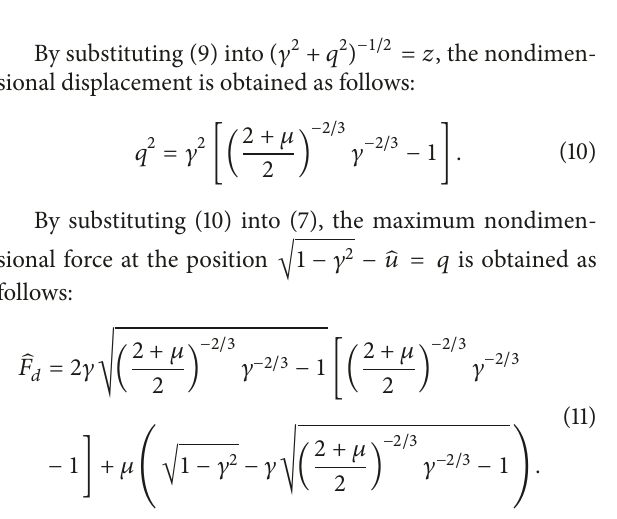
Figure 3: The nondimensional maximum force of vertical capacity of seismic isolated